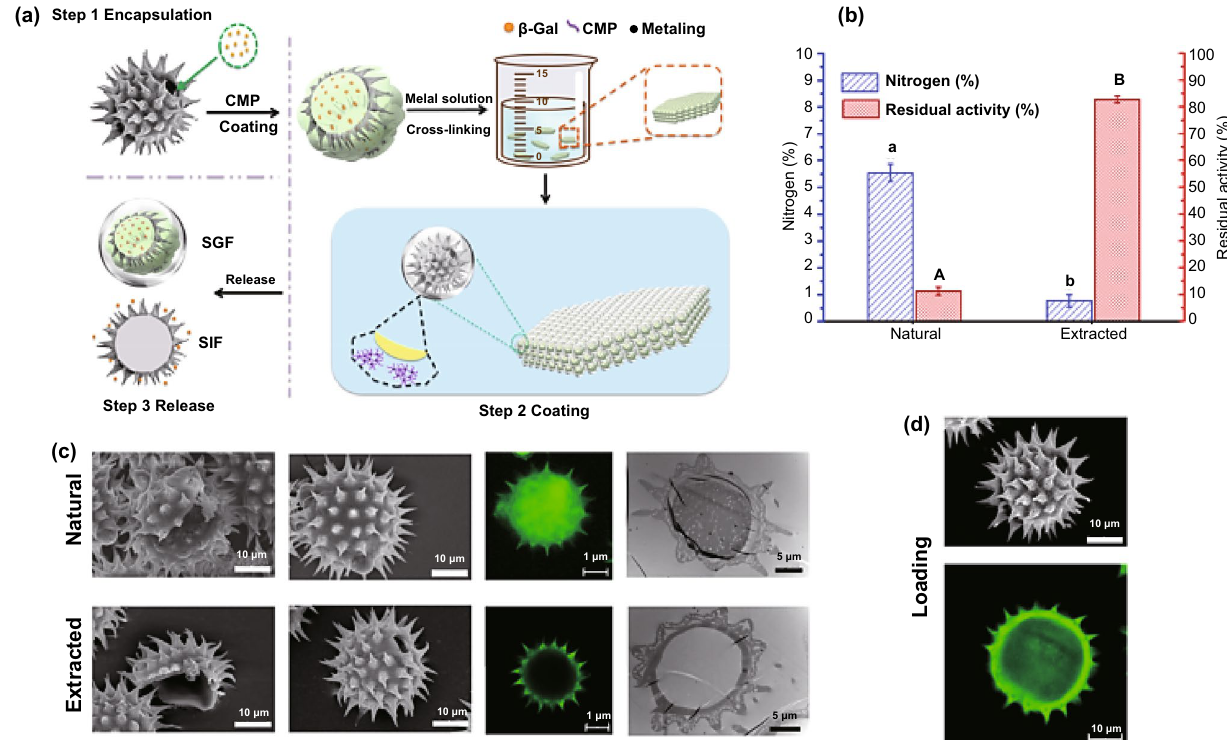
Fig. 4 a – d Design procedures of intestinal protein oral delivery system using pollen. Sporopollenin exine capsules: SECs. Reproduced with per- mission from Ref. [37] Copyright© 2020 American Chemical Society. (Color figure